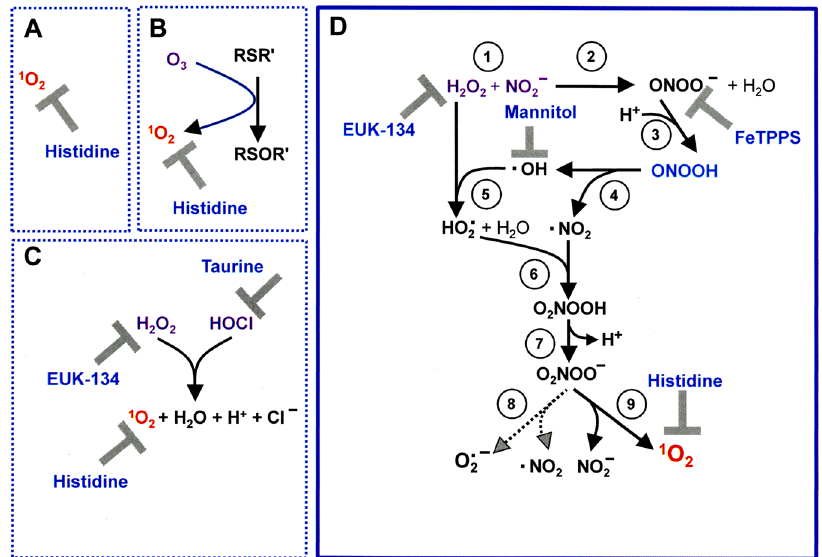
Figure 12. Conceivable ways for the generation of primary singlet oxygen. ( A ) Primary singlet oxygen ( 1 O 2 ) directly derived from the gaseous phase of CAP would only be scavenged by histidine. Due to specificity, other inhibitors used in this study would be without any effect on primary 1 O 2 . ( B ) The interaction between ozone (O 3 ) and certain amino acids can lead to the formation of 1 O 2 . ( C ) The reaction between H 2 O 2 and HOCl leads to the generation of 1 O 2 . Inhibition by the catalase mimetic EUK-134, the HOCl scavenger taurine (TAU) and the 1 O 2 scavenger histidine (HIS) would be indicative for this pathway. ( D ) The interaction of the long-lived species